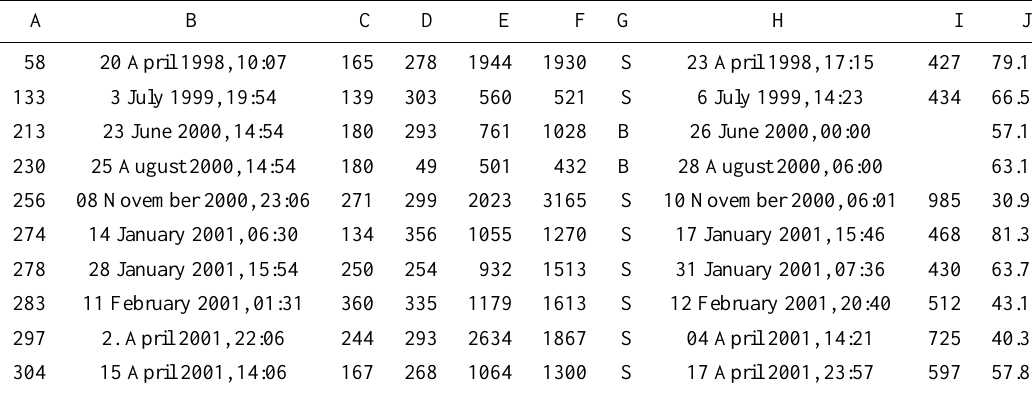
Table 6. Well-associated limb halo CMEs. The meaning of the columns: ( A ) number of events in catalog at http://star.mpae.gwdg.de/ cme effects/, ( B ) time of first appearance of CME front in LASCO-C2 field-of-view, ( C ) angular width of CME, ( D ) position angle of fastest CME feature (measured counterclockwise from North Pole), ( E ) plane of the sky speed V PS (in km/s) of fastest CME feature, measured between 10 and 20 R s using C3, ( F ) expansion speed V exp (in km/s), ( G ) detection of shock (S), plasma blob (B), ( H ) arrival time of shock or ICME at 1 AU (in ACE, Wind or SOHO data), ( I ) local shock speed (in km/s). No entry in case of no shock, ( J ) travel time (in hours) between Sun and 1 AU, determined from columns B and